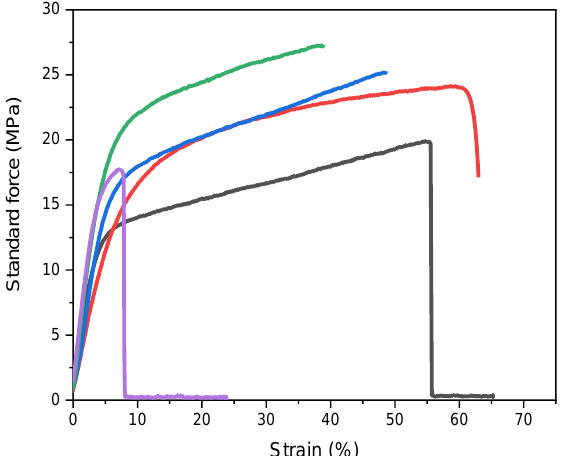
Figure 6. Tensile properties of the membranes; Nafion XL commercial membrane (red), recast Nafion membrane (black), and Nafion membranes with 5, 10, and 15 wt.% tungsten oxide (blue, green, and purple, respectively).